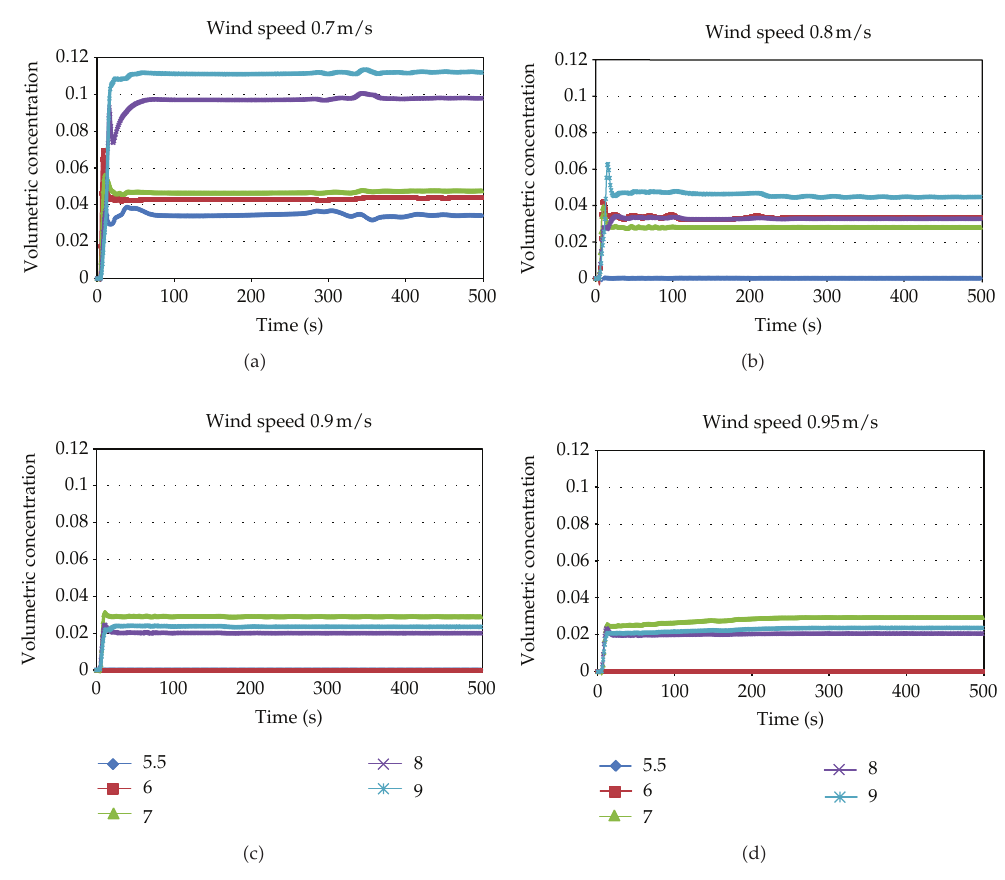
Figure 7: Model 2: volumetric concentration versus time for wind speeds 0.7 to 0.95ms − 1